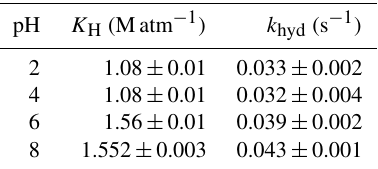
Table 2. Henry’s law constants K H and hydrolysis rate coefficients k hyd obtained as a function of pH, at T = 296K.